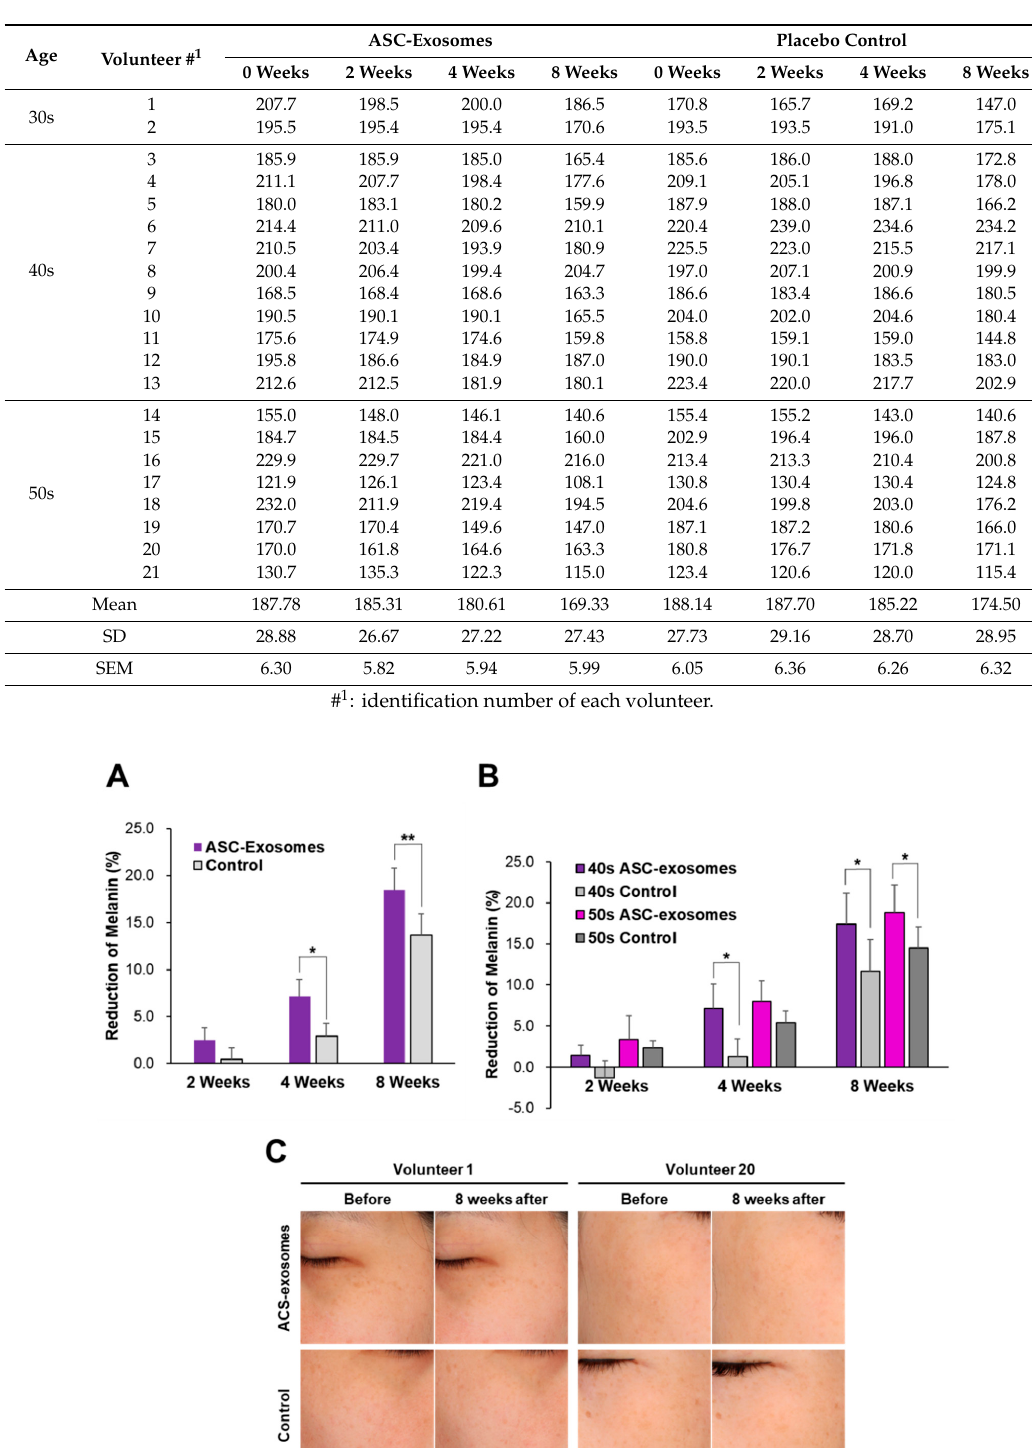
Table 1. Melanin index of each volunteer.